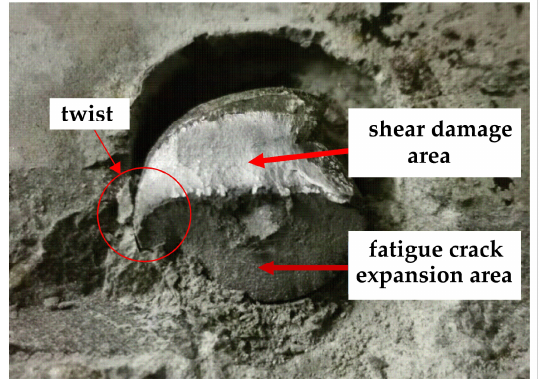
Figure 23. Cross-sectional characteristics of studs.